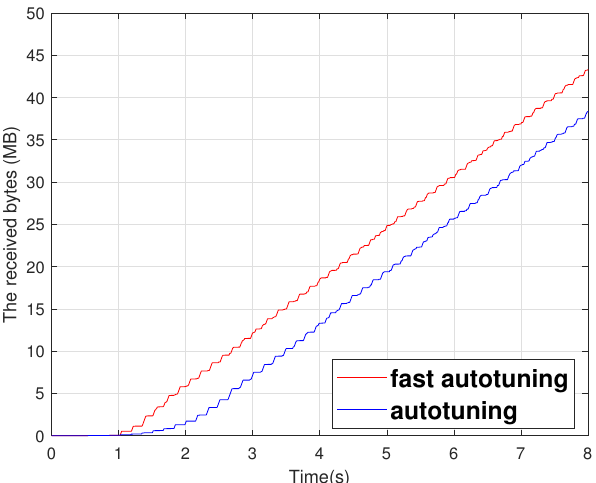
Figure 10. Received bytes of a connection with large buffer.